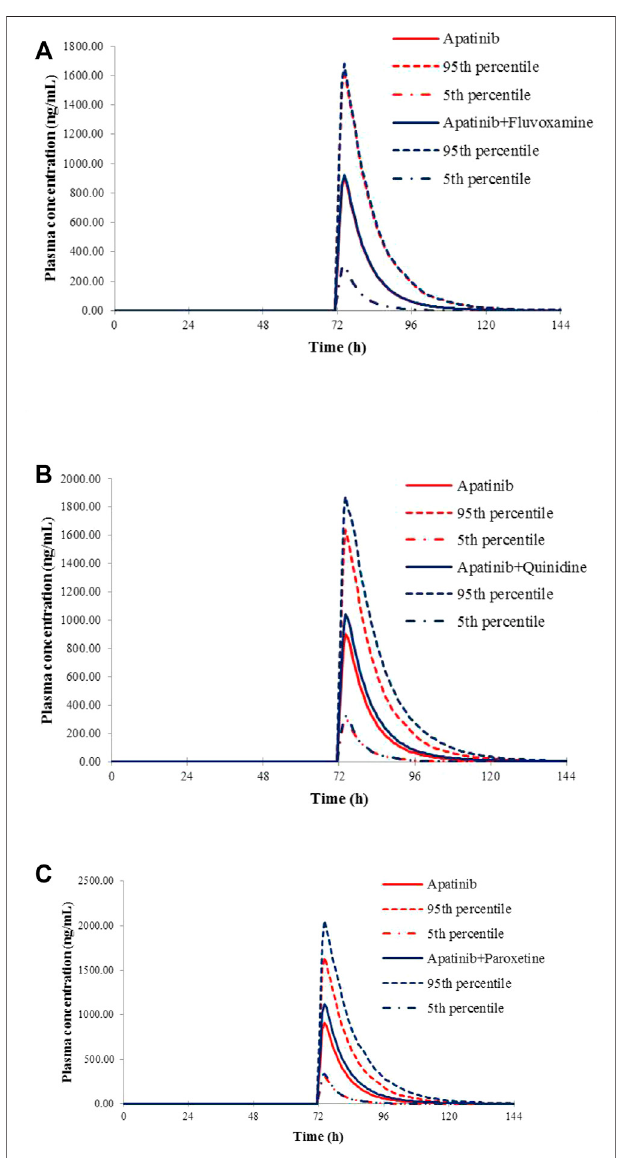
FIGURE 3 | Predicted mean plasma concentration – time curves of apatinib with or without co-administration of CYP2D6 inhibitors, fl uvoxamine (A) , quinidine (B) , and paroxetine (C)